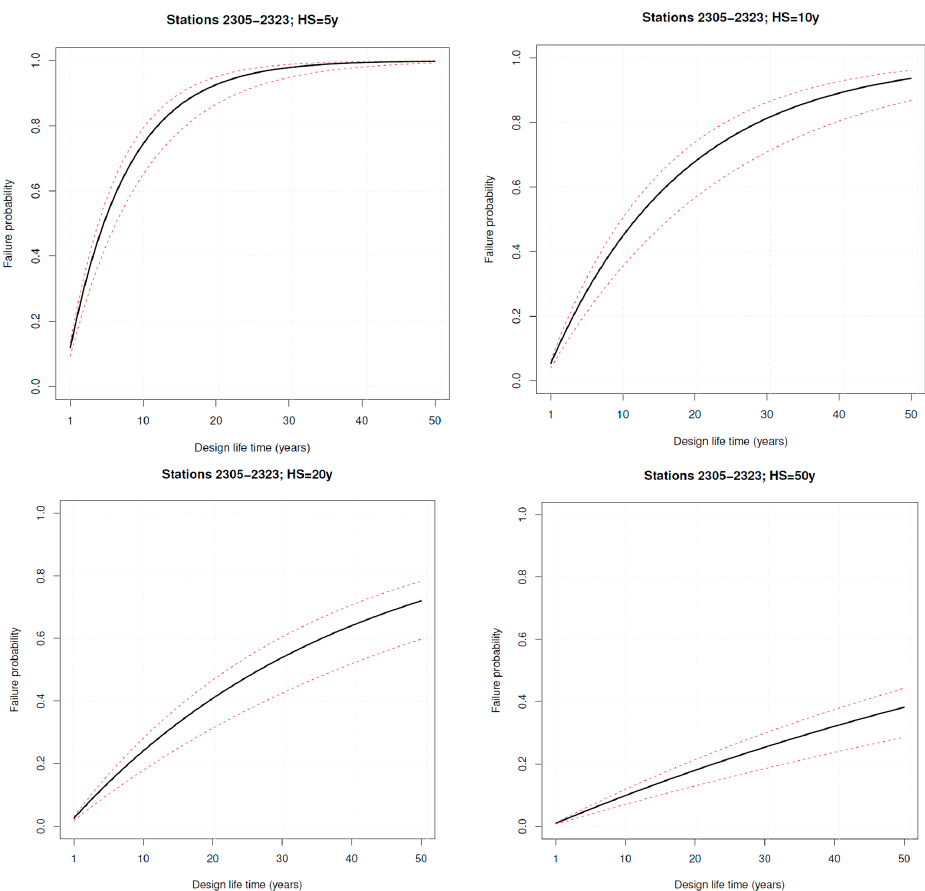
Figure 12. Middle Çoruh basin. Failure probabilities for given design life times; the dashed red lines indicate a 95% confidence band. The different plots correspond to the probability that the system enters a bivariate AND hazard scenario whose marginal critical thresholds are given by the quantiles reported in Table 5, corresponding to different return periods indicated in the main titles—see text.